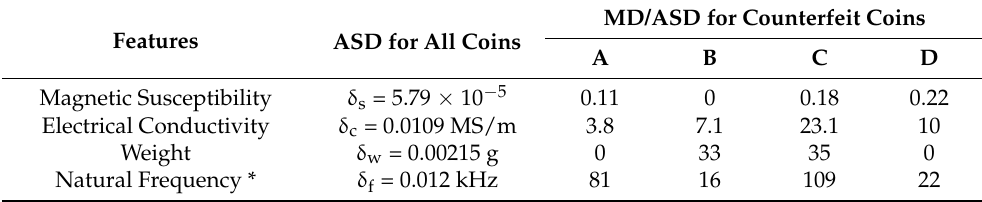
Figure 14. Distribution of the average natural frequency with respect to the ( a ) weight, ( b ) conductivity, and ( c ) susceptibility. The horizontal error bars (blue) indicate the ASDs for the weight, conductivity, and susceptibility, while the small vertical error bars (red) are the ASD for the natural frequency. Table 4. Comparison between the minimum differences (MD) of permeability, electrical conductivity, weight, and natural frequency in terms of average standard deviations (ASD).